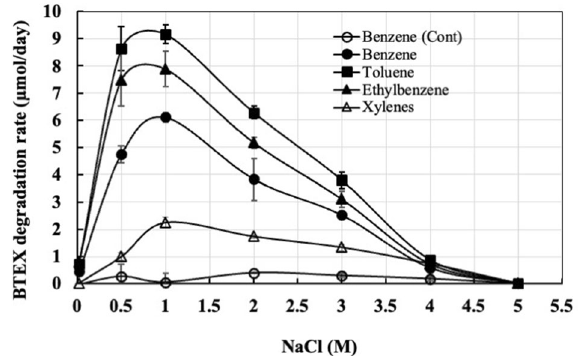
Figure 4. BTEX degradation rates in the presence of different salt (NaCl) concentration. Optimal degradation of BTEX degradation occurred at 1 M NaCl. The rates of BTEX compounds increased initially reaching maximum at 1 M NaCl and the rate decreased progressively with increasing NaCl concentration. No degradation of BTEX occurred in bottles containing 5 M NaCl over 12 weeks of incubation. Error bars indicate ± 1 standard deviation of triplicate bottles (n = 3).